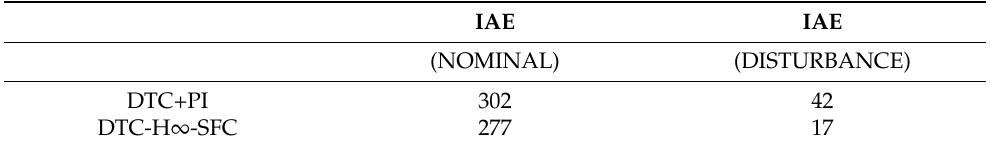
Table 3. Comparative results of integral absolute error (IAE) performance index of the control system with the DTC-H ∞ -SFC and DTC+PI designed controllers and external